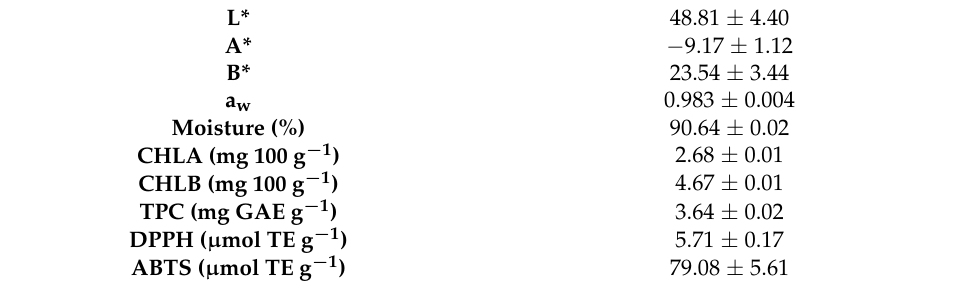
Table 2. Physicochemical and antioxidant characterization of basil leaves.